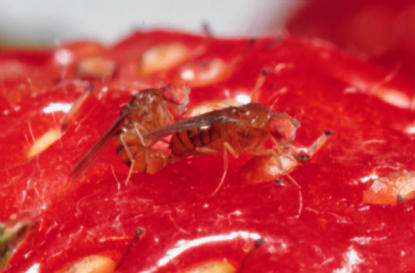
An evolutionary experiment that manipulated the resource environment of Australian fruitflies (shown mating on a strawberry) showed that female mating preference can evolve, at least in part, in correlation with the environment. (Image: A. O'Toole, University of Queensland)